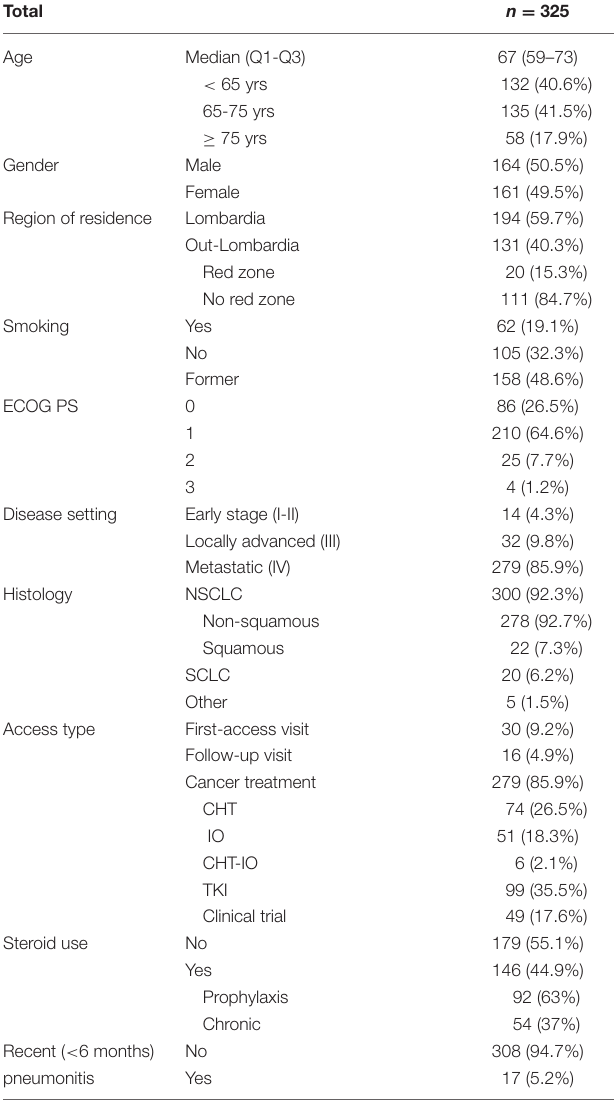
TABLE 1 | Clinical characteristics of study